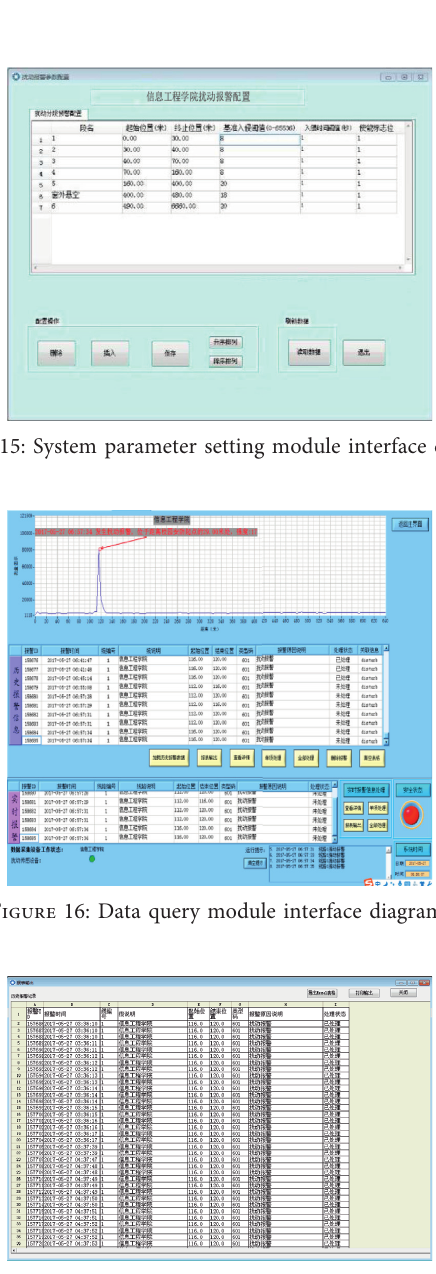
Figure 17: Report output module interface